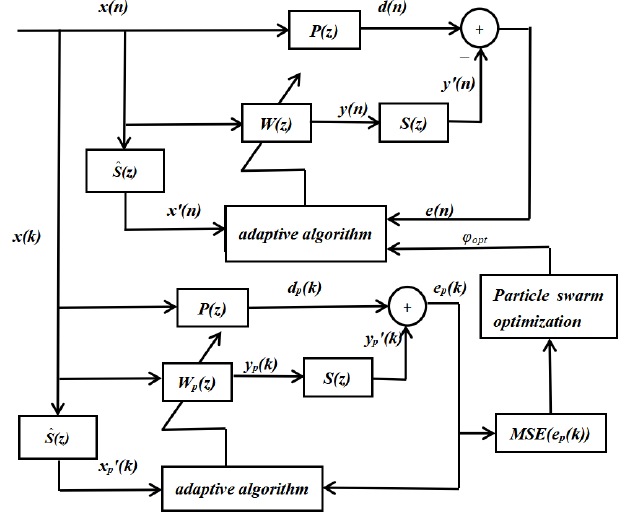
Figure 4. Principle diagram of the FxLMS algorithm system for particle swarm optimization with adaptive step size.